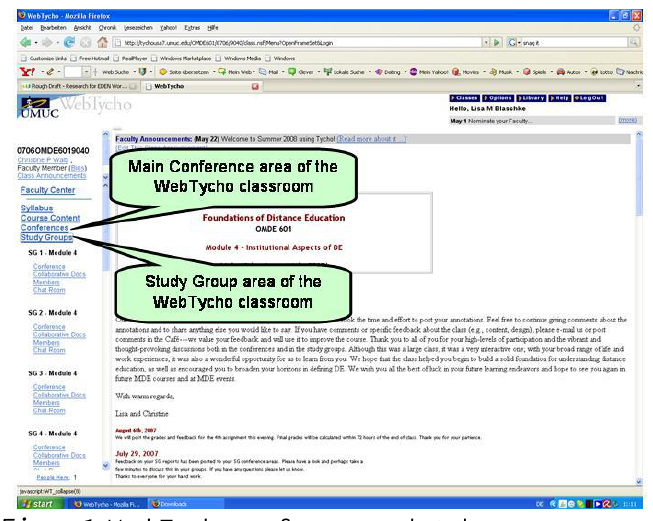
Figure 1 : WebTycho conferences and study group